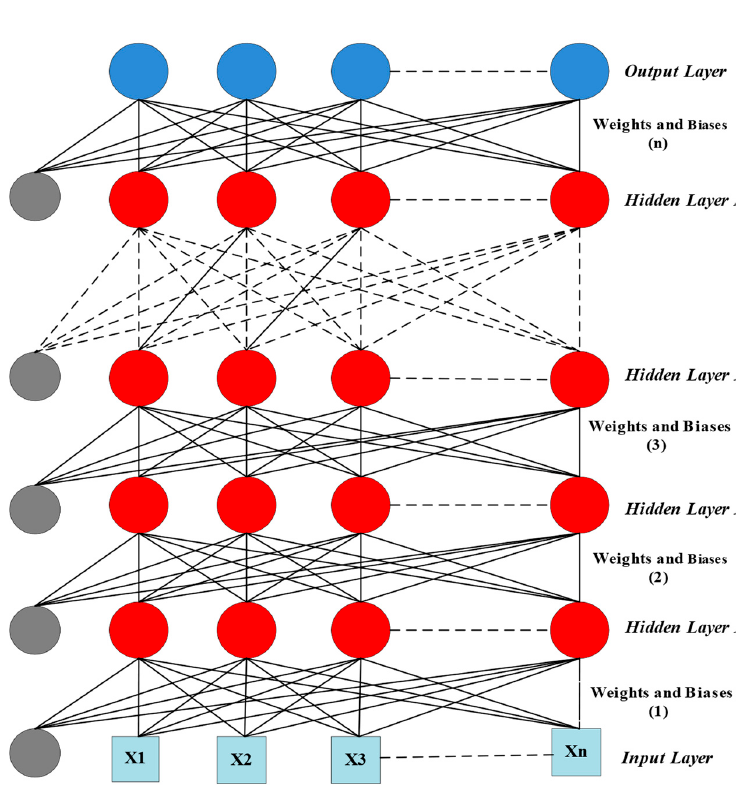
Figure 1. Frameworks of multilayer neural network structure.